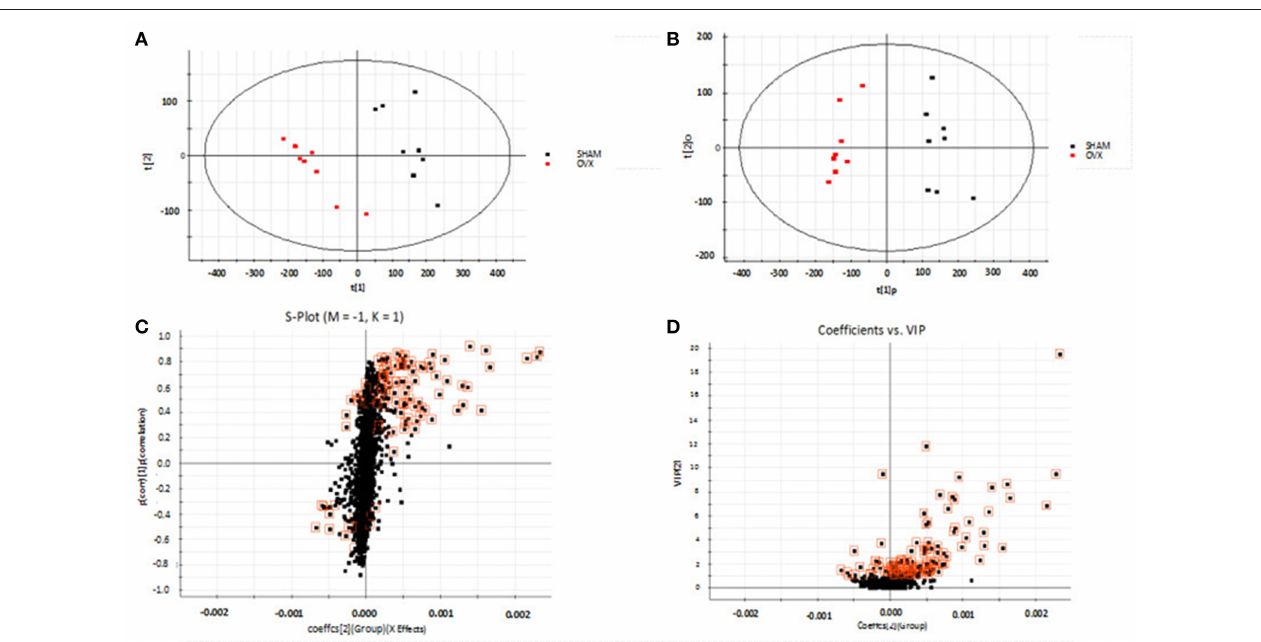
FIGURE 4 | Metabolomics profiling of ovariectomized osteoporosis in negative ion mode at 7 weeks: (A) score plot of serum profile of sham operation group and model group scanned by PCA analysis. (B) Score plot of serum profile of sham operation group and model group scanned by OPLS-DA analysis. (C) S-plot of serum profile of sham operation group and model group scanned by OPLS-DA analysis. (D) VIP-plot of serum profile of sham operation group and model group scanned by OPLS-DA analysis.